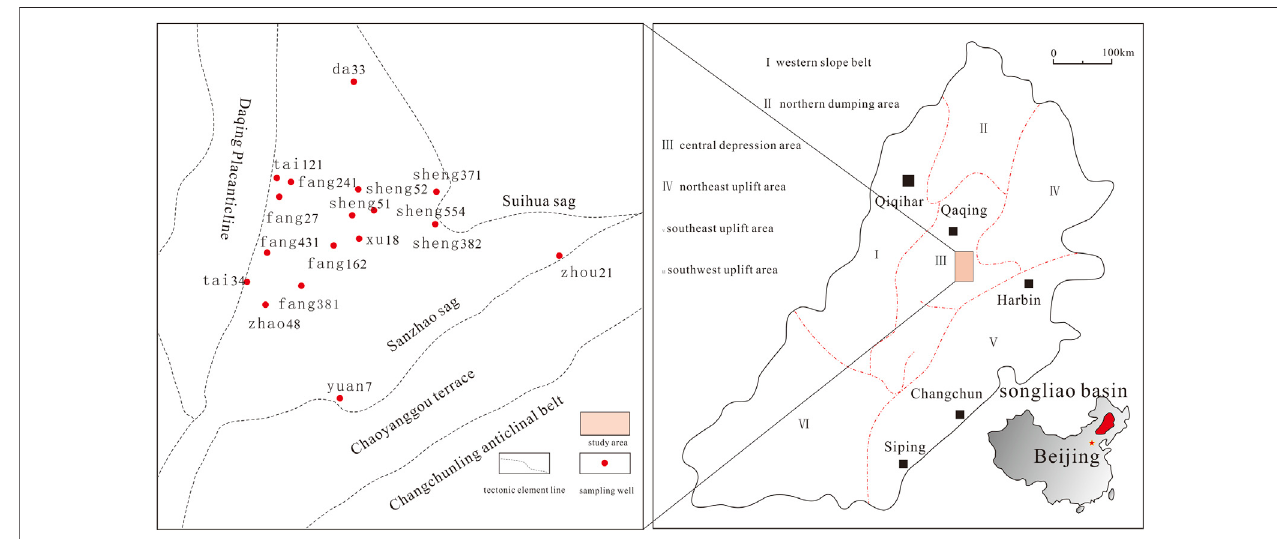
FIGURE 2 | Location of the study area and the distribution of the fl uid inclusion sampling well.